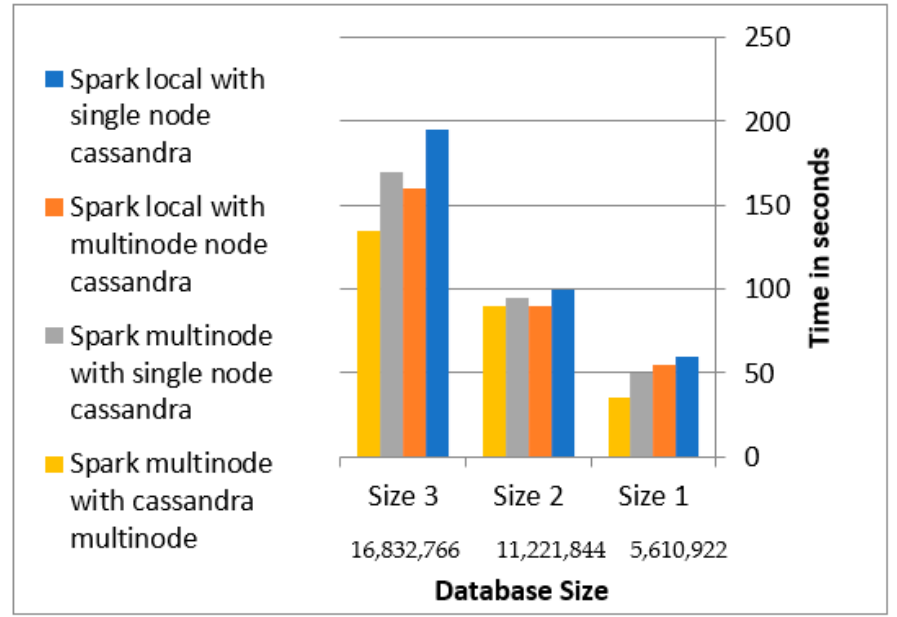
Figure 11. Elapsed time for executing query on Cassandra using the proposed layer.